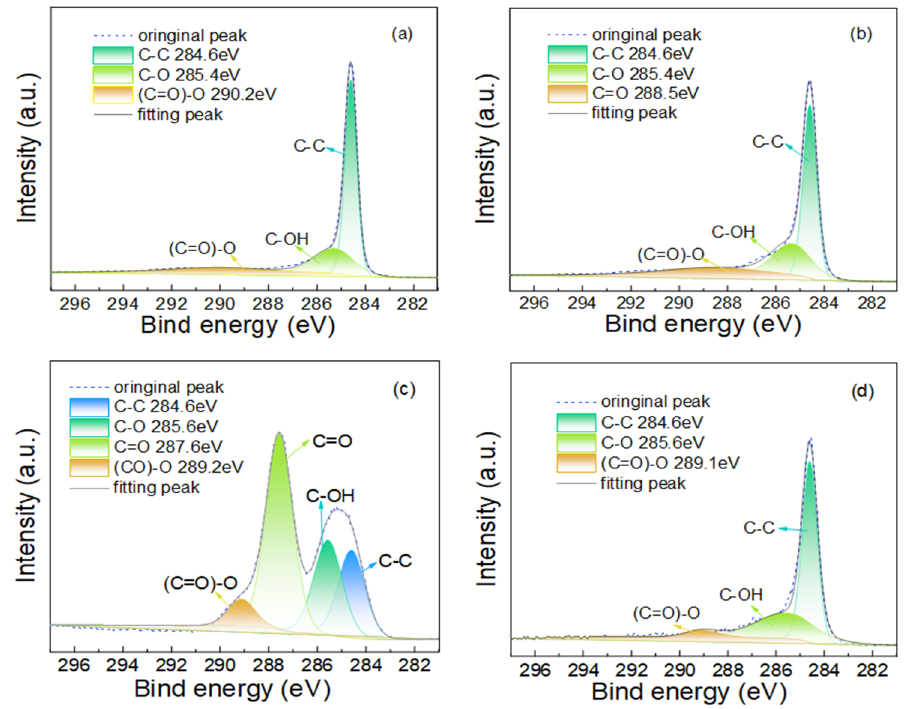
Figure 3. Curve-fitting of C 1s XPS spectra of ( a ) G1, ( b ) G2, ( c ) GO, and ( d ) rGO. Table 1. XPS compositions of prepared GN and GO.